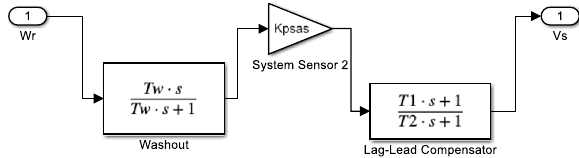
Fig. 4 Power System Automation and Stabilization Control Circuit